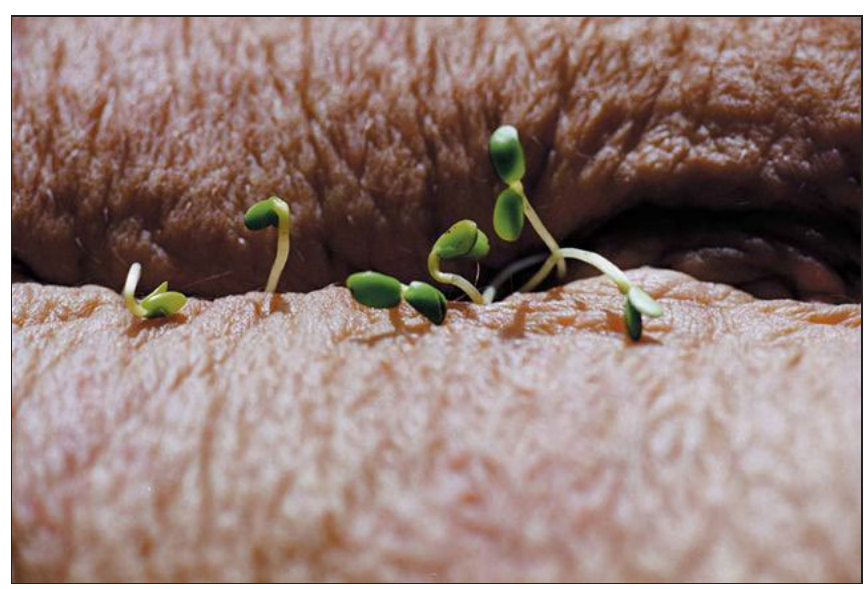
Figure 34: Shira Richter, Sprouts from the Mother, Daughter, and Holy Spirit series , C-prints, 120x180 centimeters, 2004.